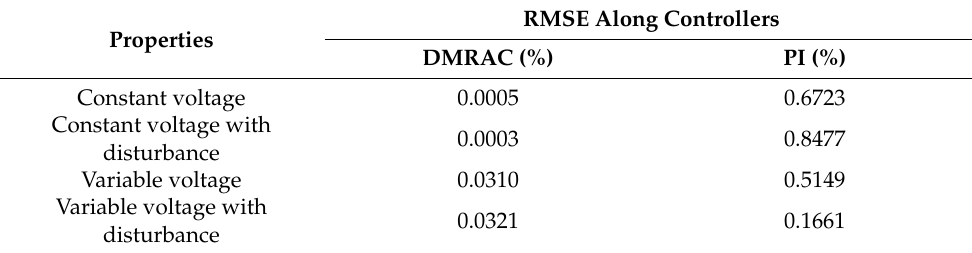
Table 3. RMSE for both DMRAC and PI